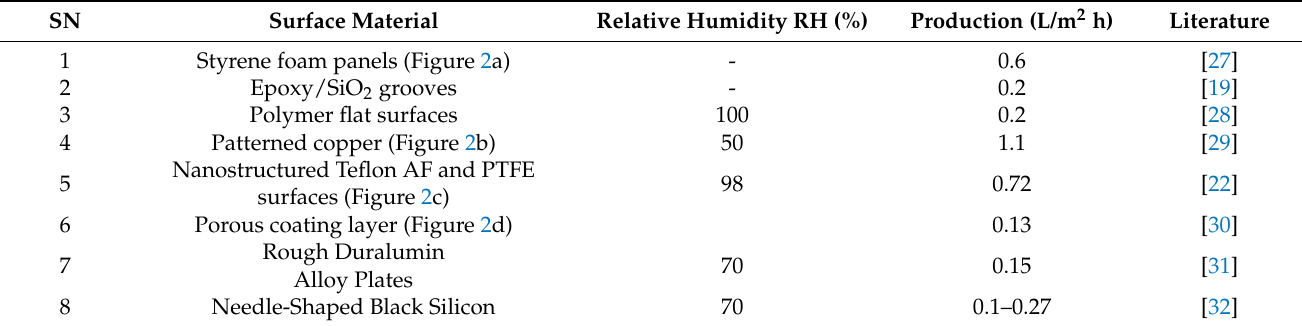
Table 1. Comparison of several key research on dew water